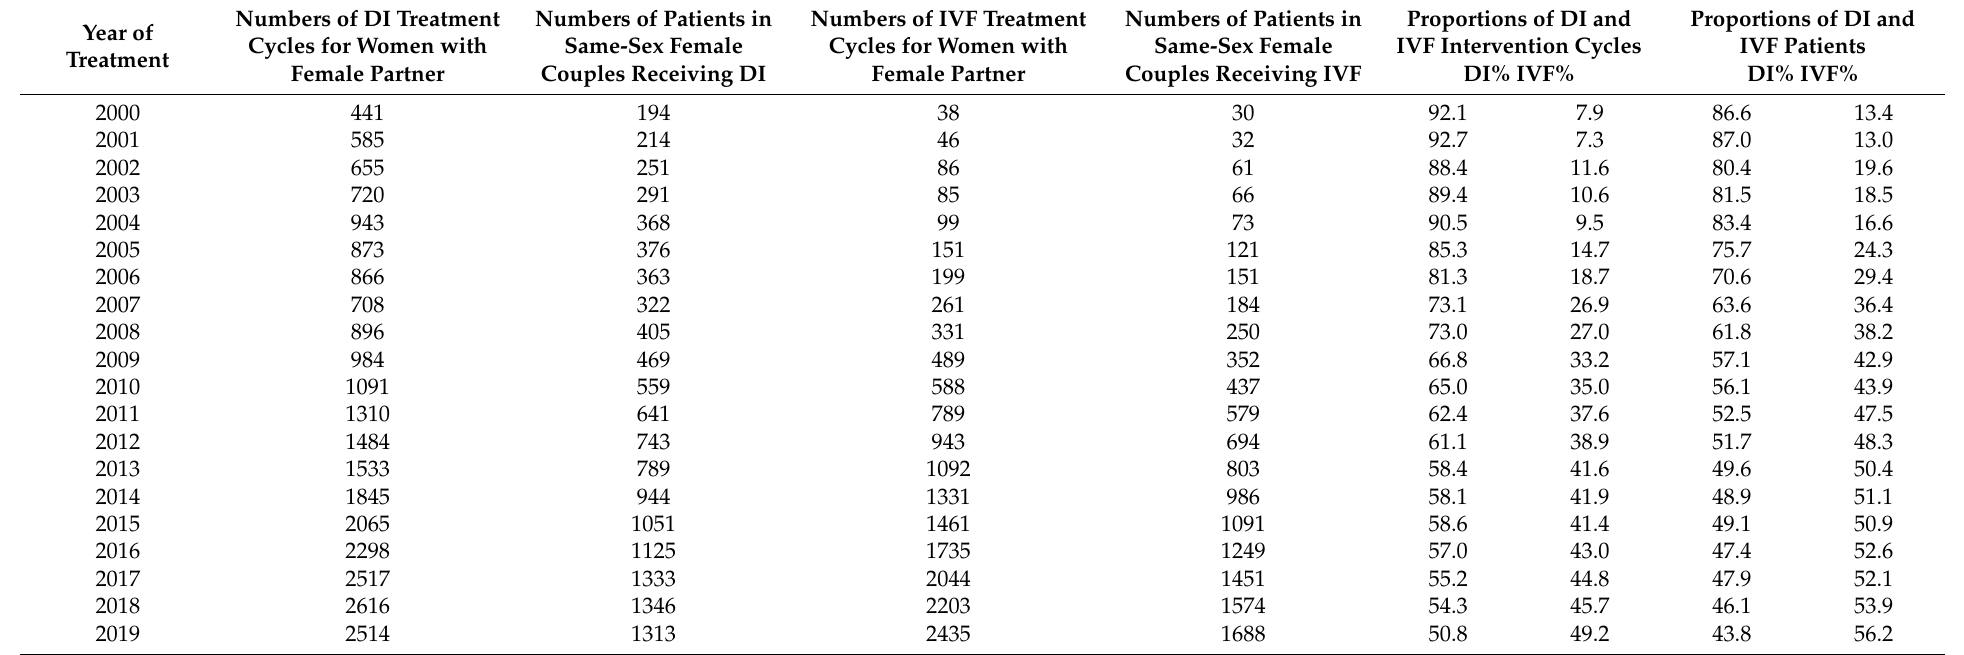
Table 1. Numbers of patients and in-vitro fertilisation (IVF) and donor insemination (DI) treatment cycles with relative